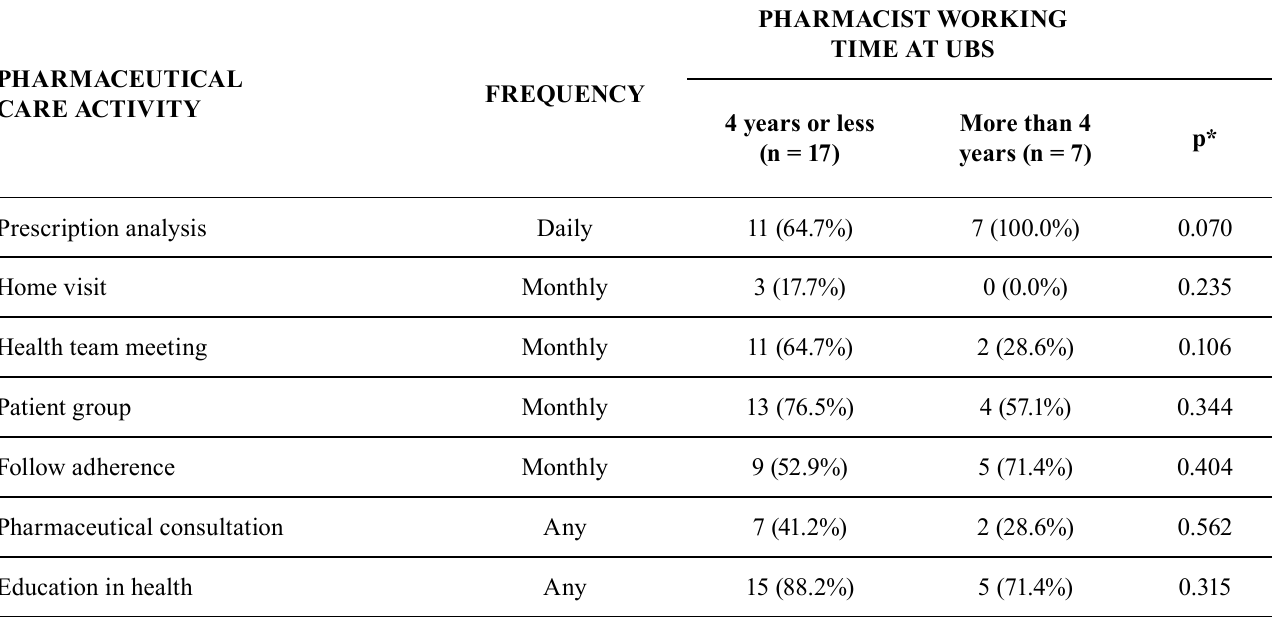
TABLE III – Association of pharmacists working time with the frequency of Pharmaceutical Care activities in the primary health centers (UBS) of São Bernardo do Campo, 2018